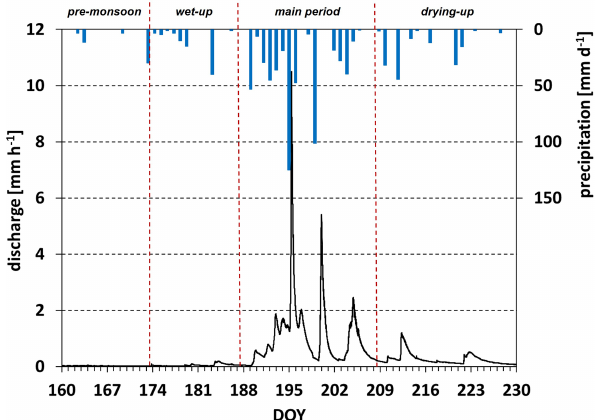
Figure 2. Daily precipitation rates and discharge time series for the monsoon season in 2013 (9 June to 18 August; i.e., day of year, DOY, 160–230). The monsoon season was separated into four peri- ods based on the precipitation and hydrological